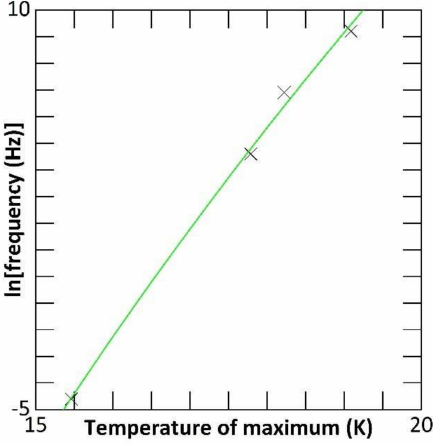
Figure 6. Vogel-Fulcher fit for lead niobate pyrochlore. Temperature values of maxima determined from dielectric data of Siegwarth et al.